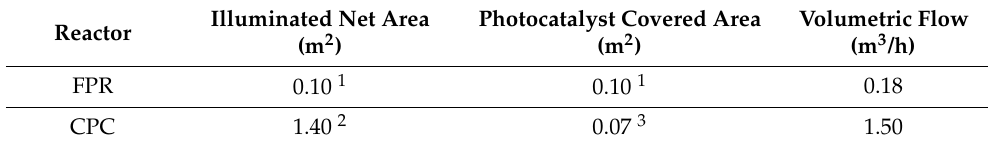
Table 5. Different operational parameters between